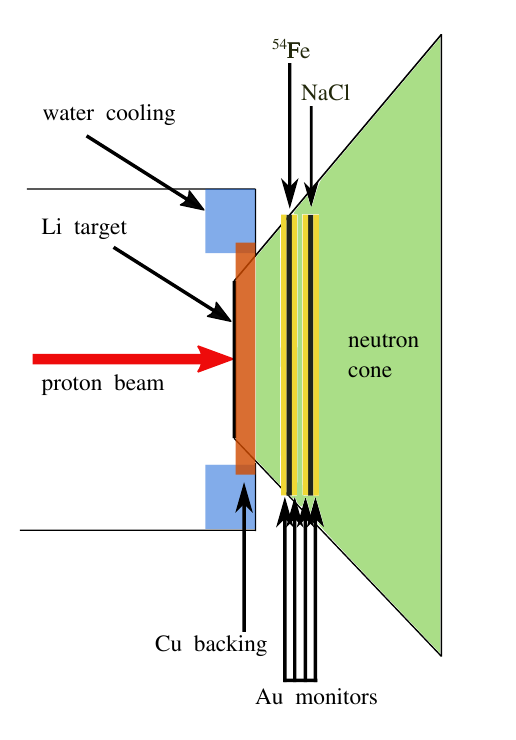
Figure 2. Schematic setup for the neutron production target at the FRANZ facility and the NaCl and 54 Fe irradiation